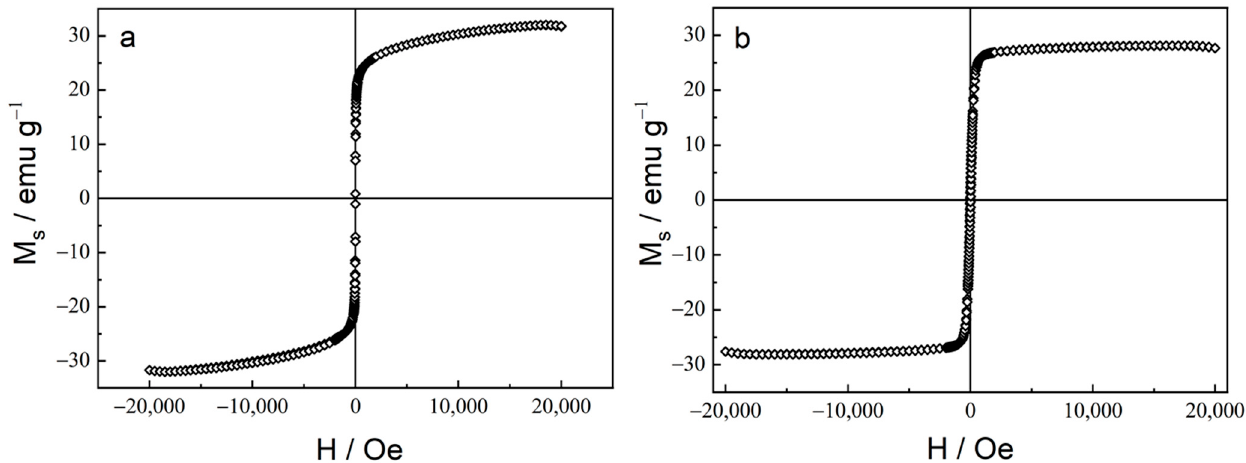
Figure 6. Hysteresis loops of Fe-W-P coatings. ( a ) 8 at.% P, 6 at.% W; ( b ) 13 at.% P, 6 at.% W, recorded with an external magnetic field applied along the in-plane direction.